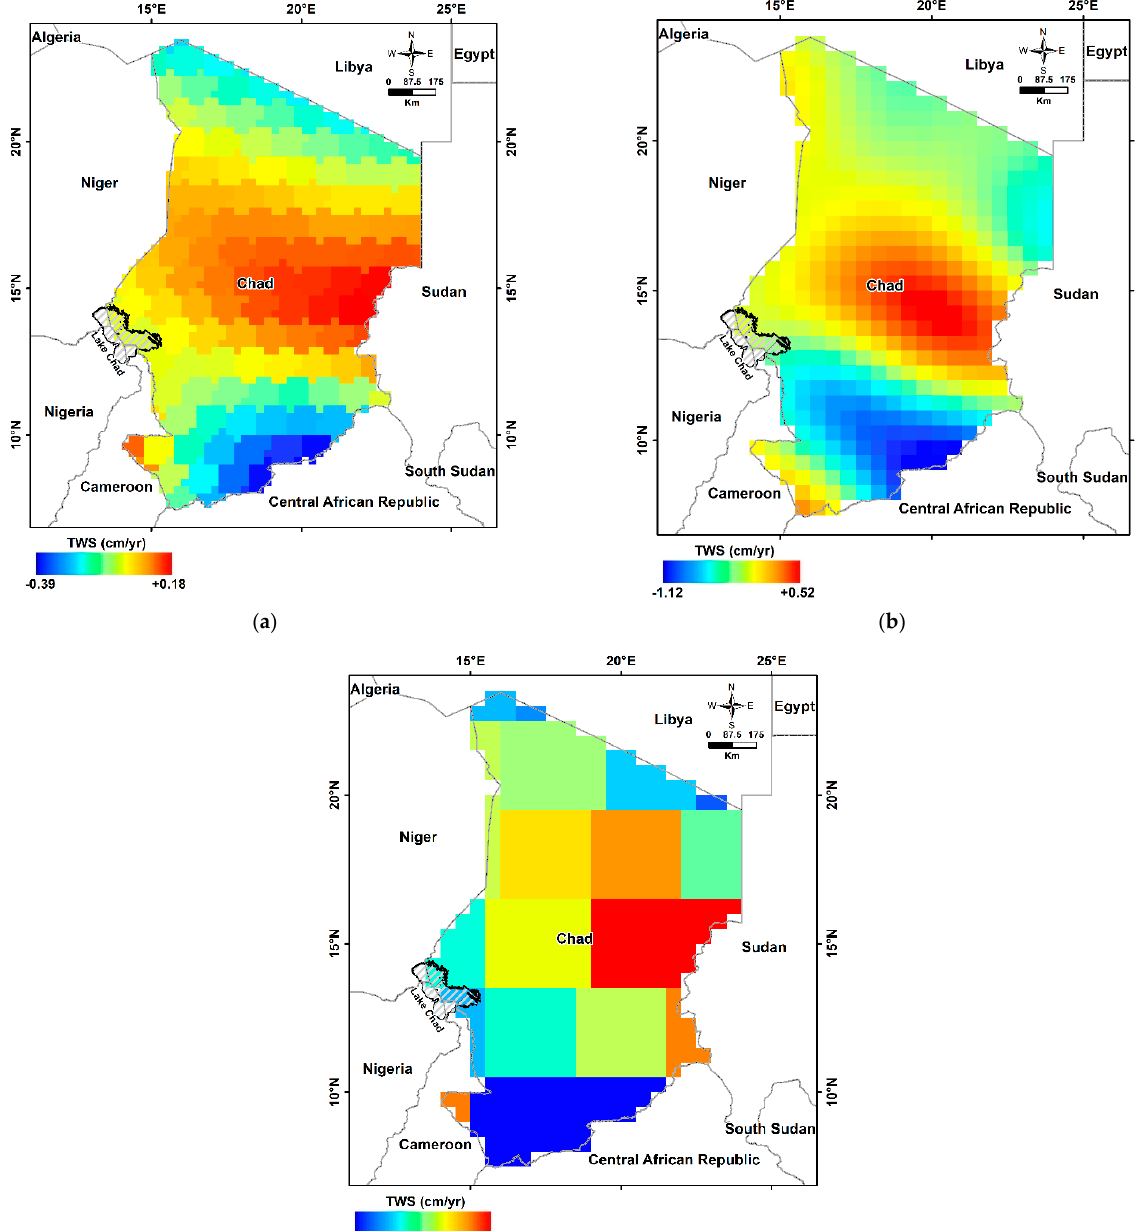
Figure 5. Spatiotemporal variation map of the Δ TWS trend during Period I from CSR ( a ), GSFC ( b ), and JPL ( c ) mascon products.